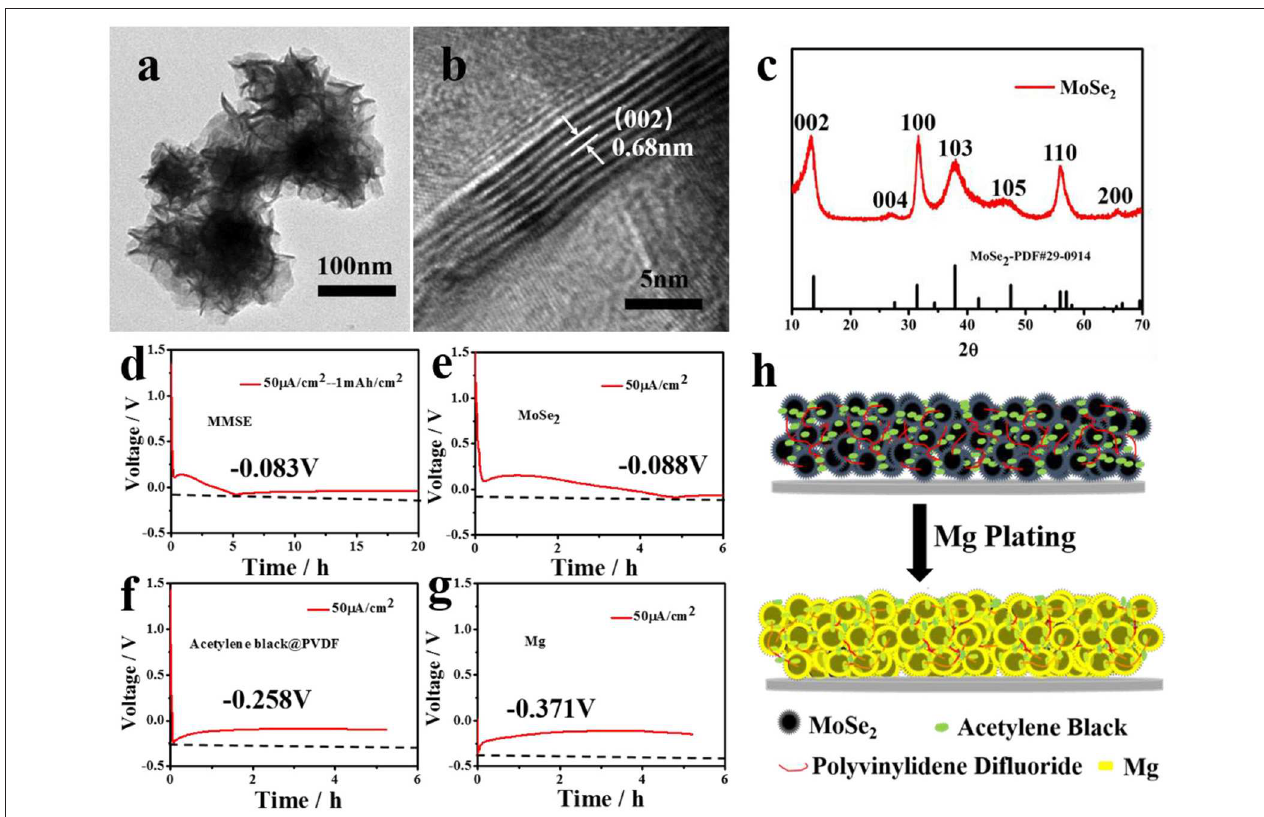
FIGURE 1 | (a) TEM image, (b) HRTEM image, and (c) XRD spectrum of MoSe 2 . (d–g) Electrochemical curves showing the Mg deposition behavior on (d) MMSE, (e) MoSe 2 , (f) Acetylene black and PVDF, and (g) Mg. The current density was fixed at 50 µ A/cm 2 for Mg plating processes. (h) Schematic showing the Mg deposition behavior on